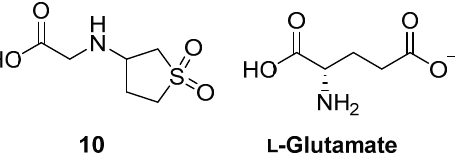
Figure 3. Cyclic sulfone 10 and the GS substrate, L